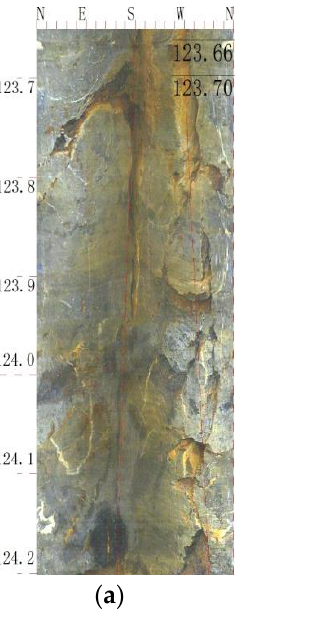
Figure 4. Water-conducting fractured zone detected in borehole CK-1: ( a ) at depth 123.6 to 124.2 m; ( b ) at depth 139.1 to 139.7 m.